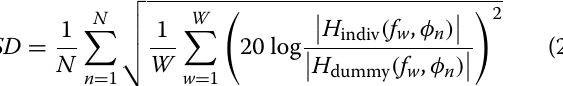
bands centered on 500 Hz, 2000 Hz and 5000 Hz, as employed in [47].